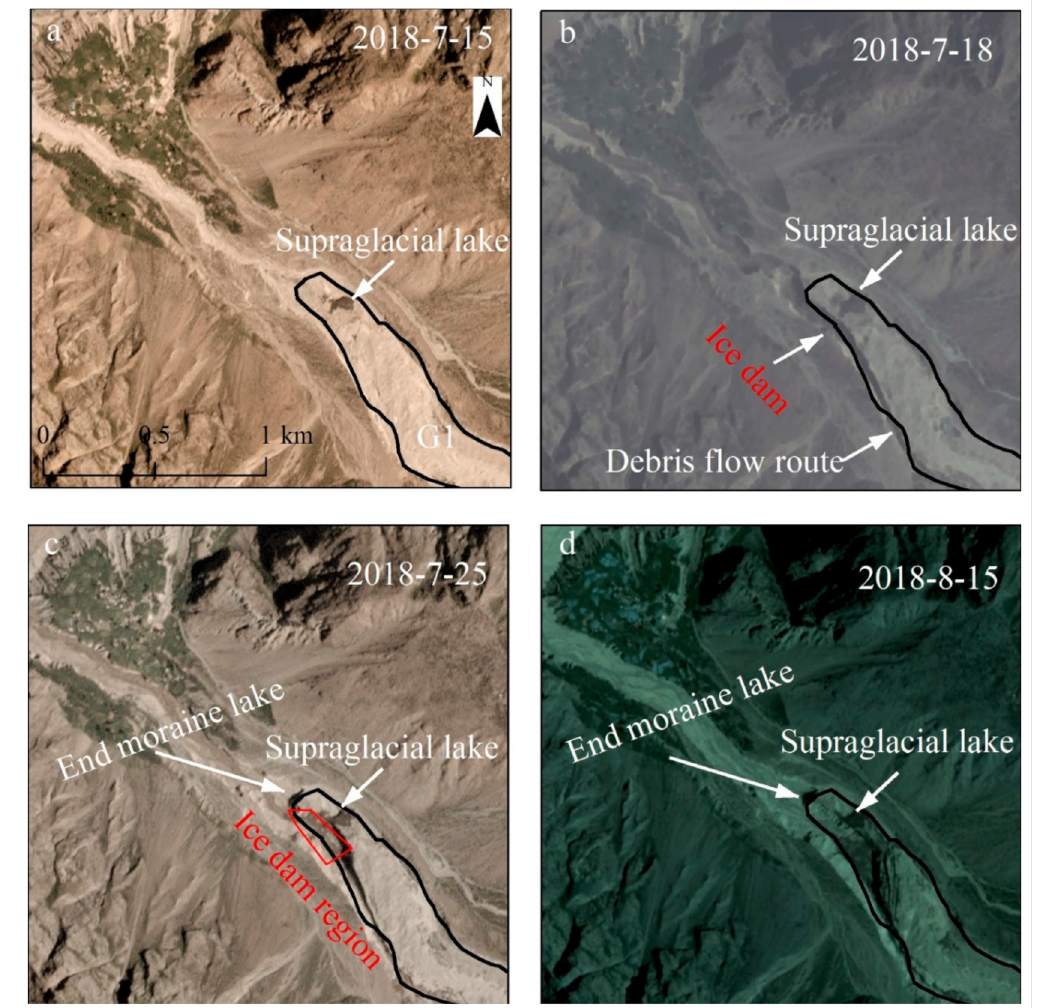
Figure 4. Satellite images of the G1 snout ( a – d ) before and after the events from 15 July 2018 to 15 August 2018 (background: Planet Scope. ( a ) before the event at G1; ( b ) after the event without end moraine lake; ( c , d ) after the event with end moraine